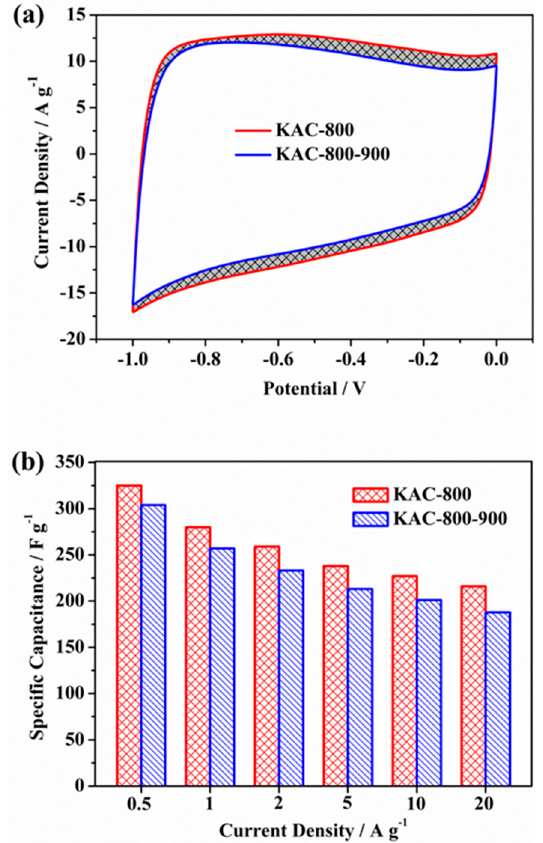
Figure 6. ( a ) Comparison of CV curves of KAC-800 and KAC-800-900 at the scan rate of 50 mV s − 1 ; ( b ) specific capacitances of KAC-800 and KAC-800-900 as a function of the current densities.